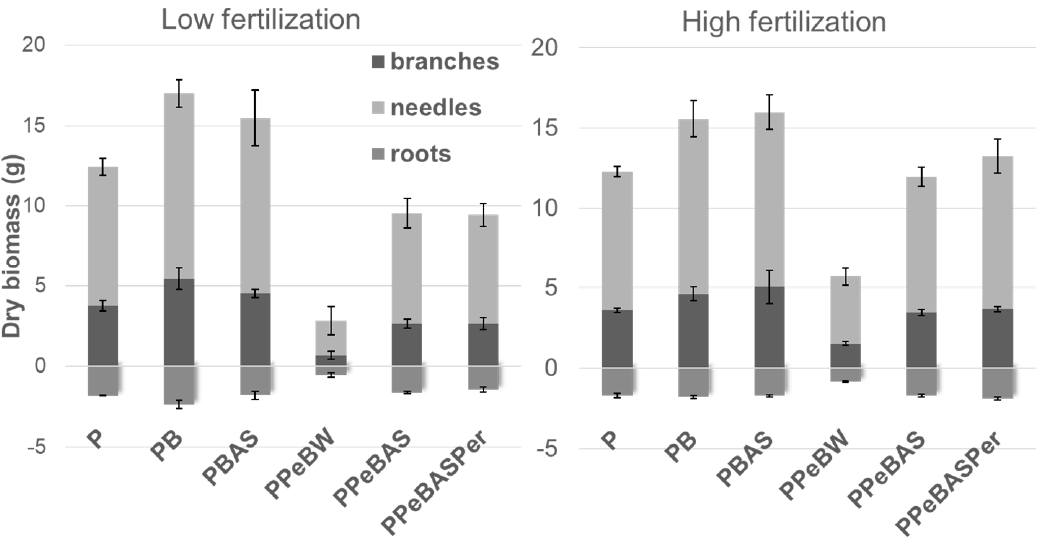
Figure 5. Dry biomass of spruce seedlings (collected after 23 weeks) growing on the different types of substrates: 100% peat (P), 75% peat plus 25% bulk biochar (PB), 75% peat plus 25% bulk biochar impregnated with ammonium sulfate (PBAS), 75% peat plus 25% biochar pellets with water (PPeBW), 75% peat plus 25% biochar pellets with ammonium sulfate (PPeBAS) and 62.5% peat plus 25% biochar pellets with ammonium sulfate plus 12.5% perlite (PPeBASPer), with low (half) and high doses (full) of fertilizer.